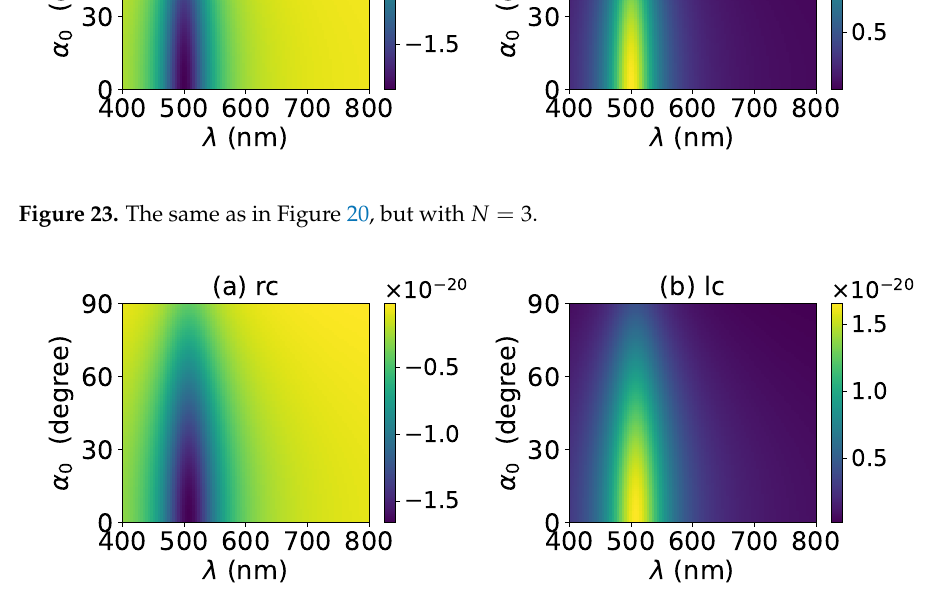
Figure 24. The same as in Figure 20, but with N =